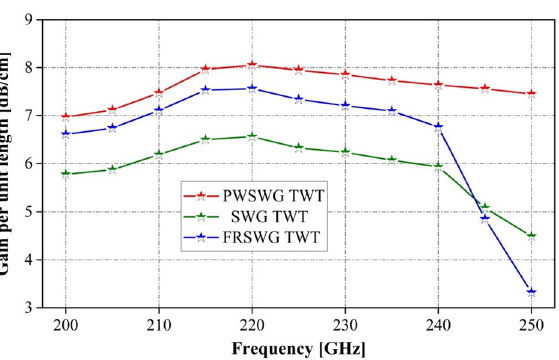
Figure 17. Comparison of gains per unit length of the PWSWG TWT, the SWG TWT and the FRSWG